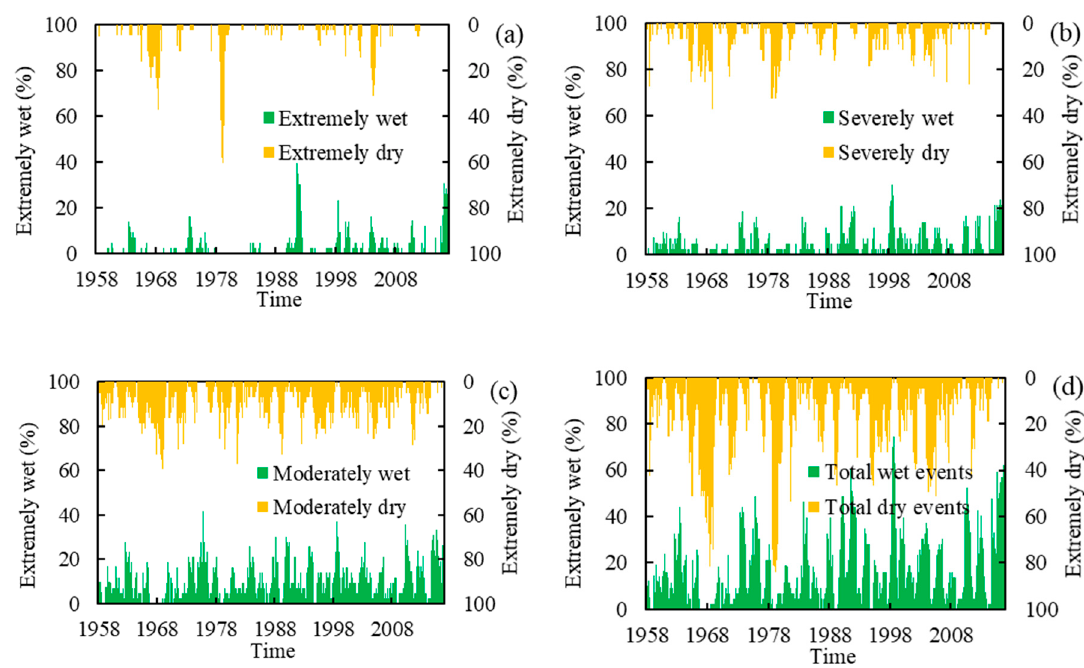
Figure 5. Percentages of stations affected by different types of wet/dry events.